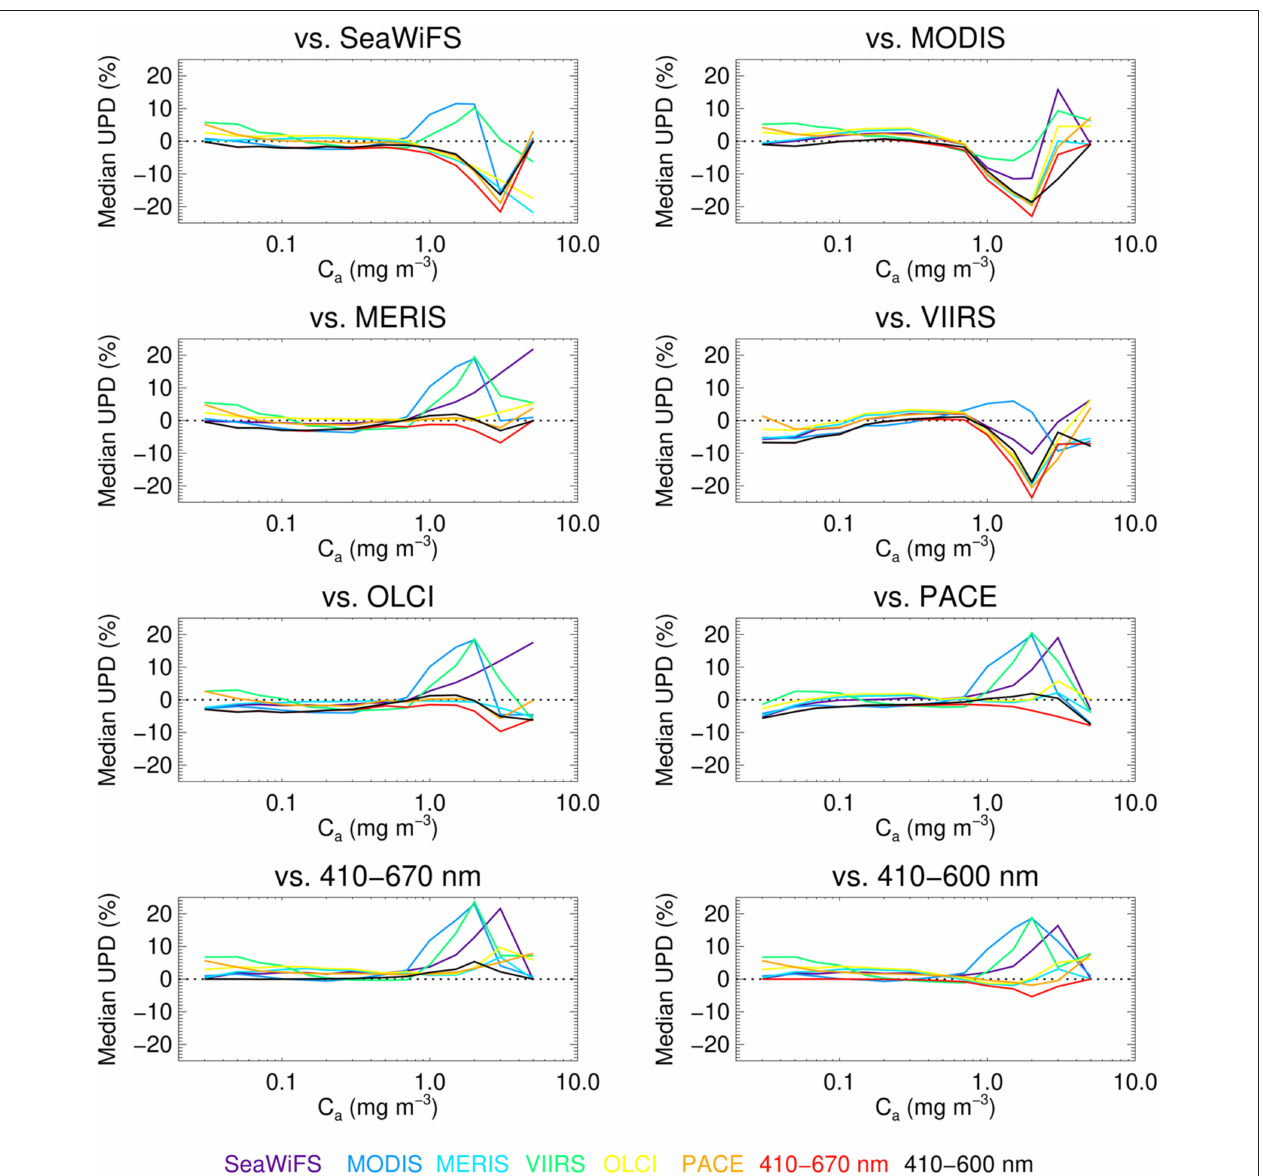
FIGURE 12 | As for Figure 9 , but for b bp